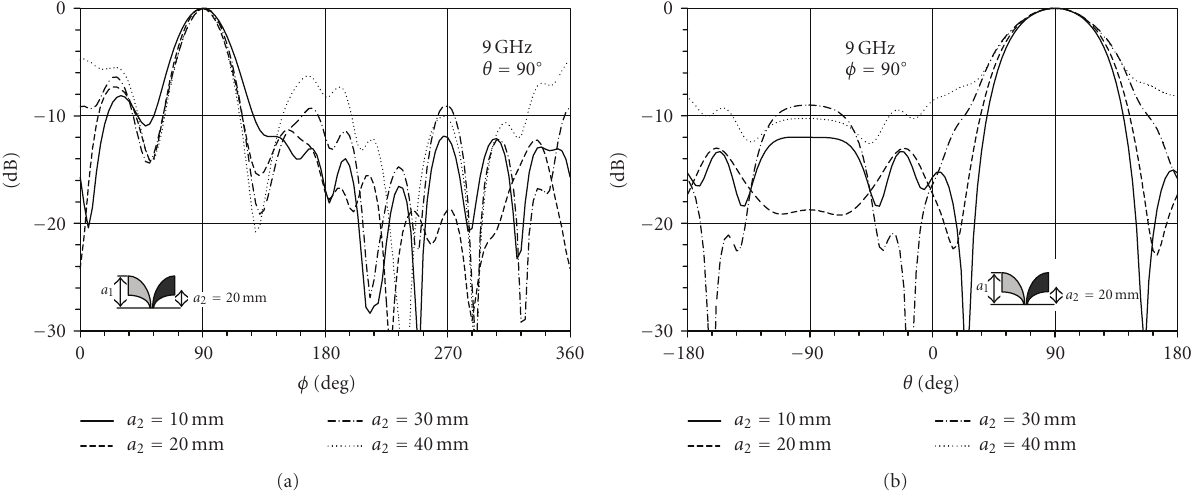
Figure 12: Radiation patterns of DETASAs for varying length of outer taper, a 2 , in (a) E-plane, (b)